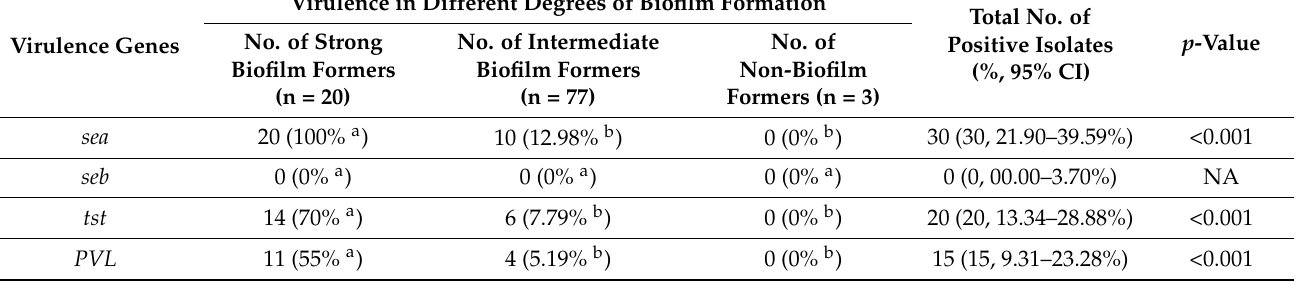
Table 1. Detection of virulence genes in biofilm-forming S. aureus strains (n = 100) isolated from different foods and hand swab samples.